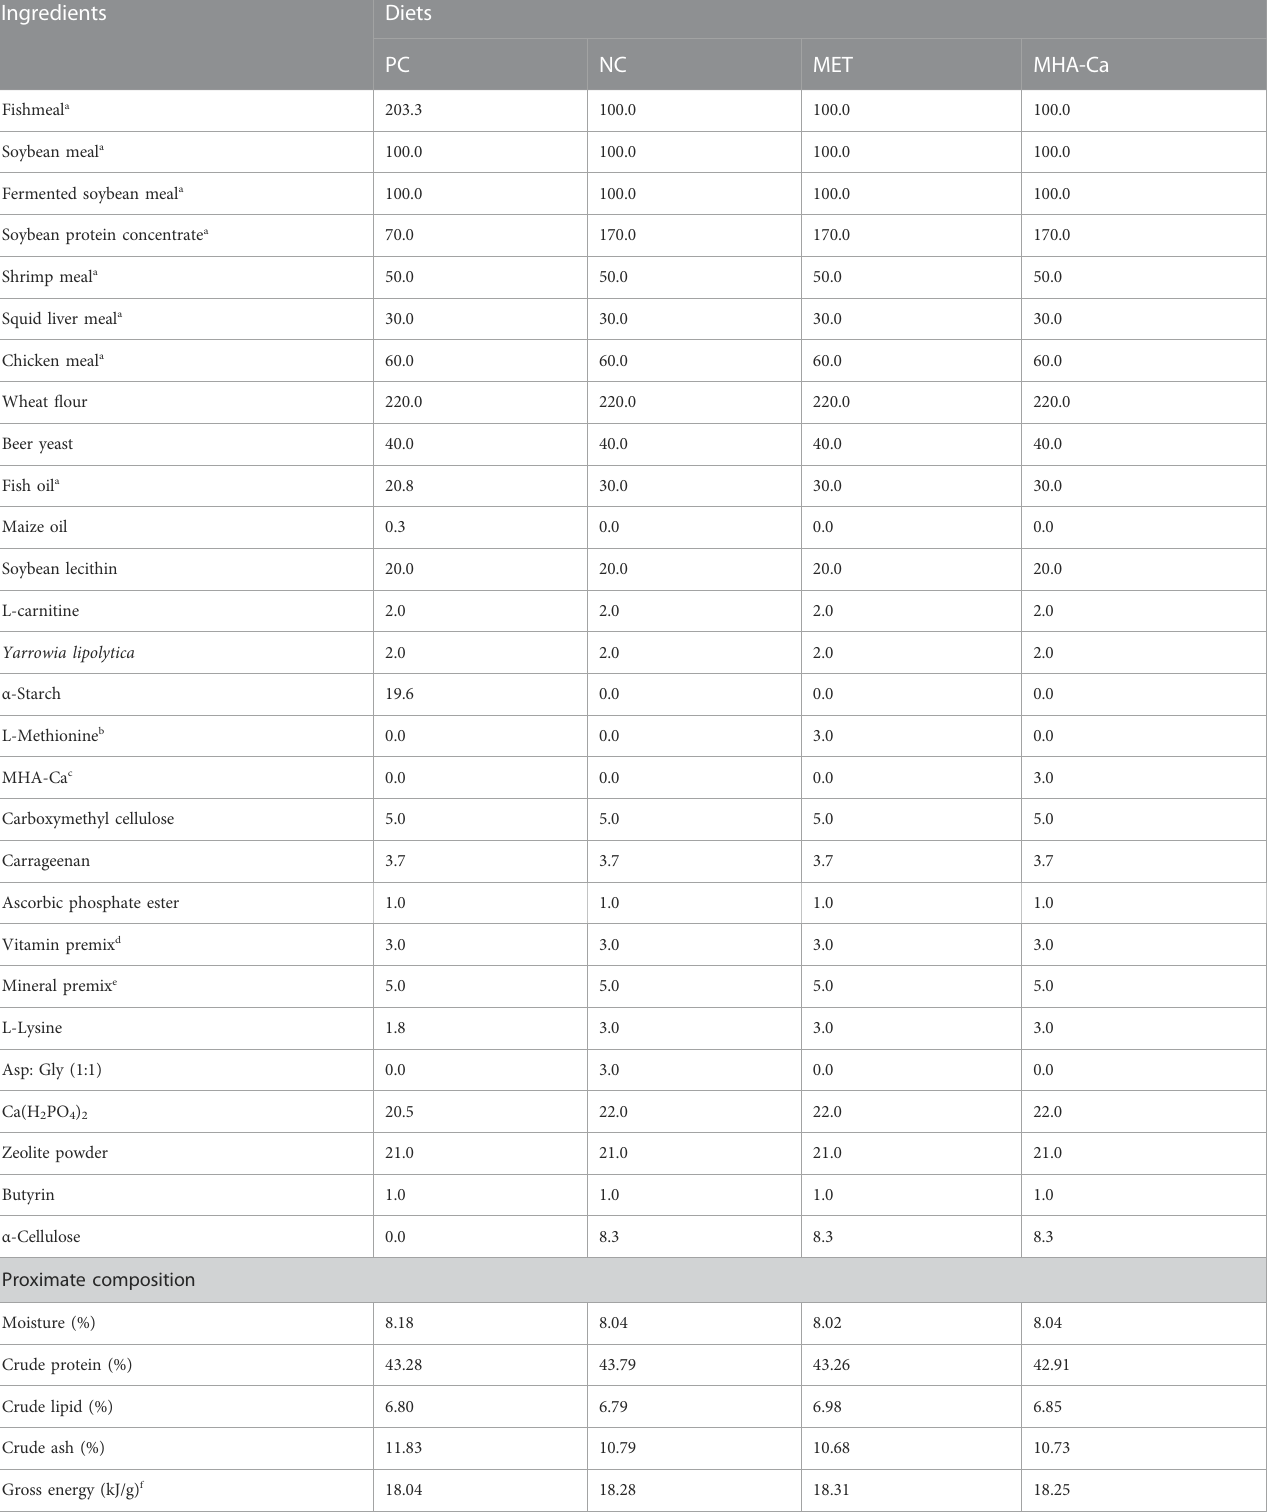
TABLE 1 Formulation and proximate composition of the experimental diets (g/kg diet).